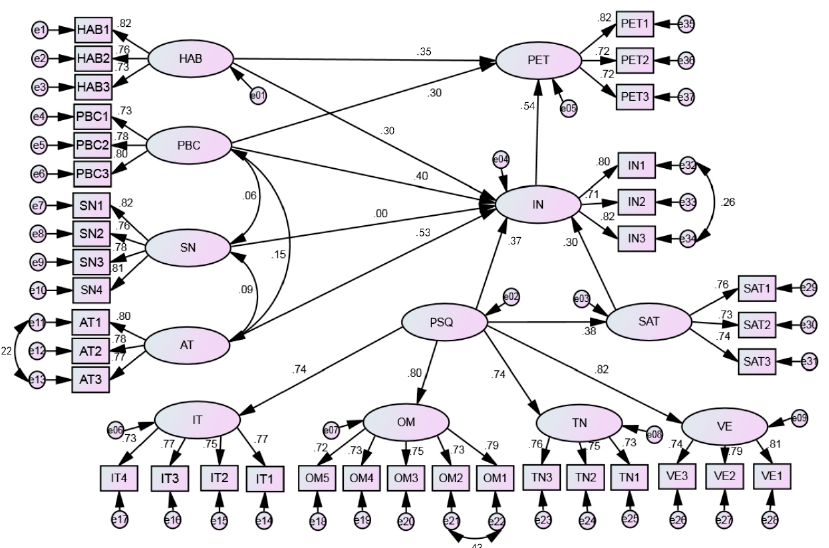
Figure 4. Structural equation model (SEM) framework diagram of public transport (PT) service quality PET behaviour model.